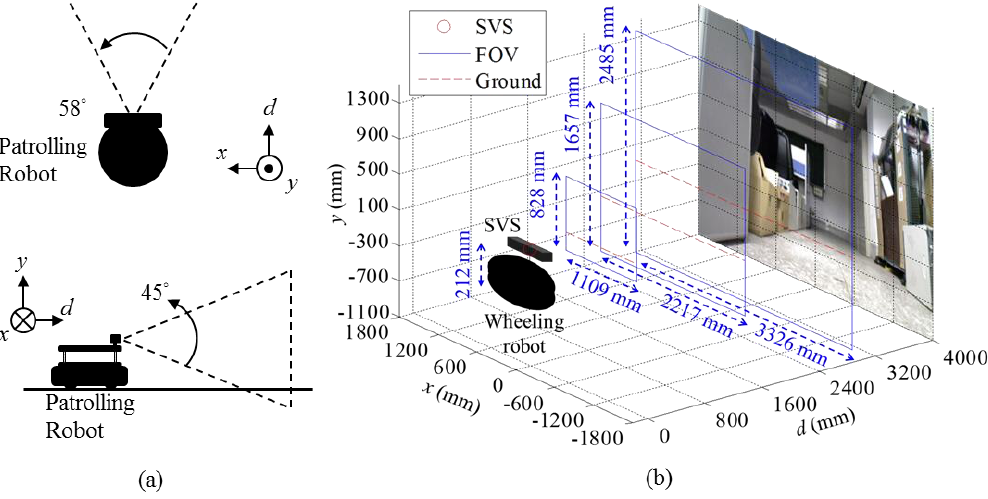
Figure 4. ( a ) The plan and side views and ( b ) the field of view (FOV) of stereo vision system (SVS) at various distances of the robot.